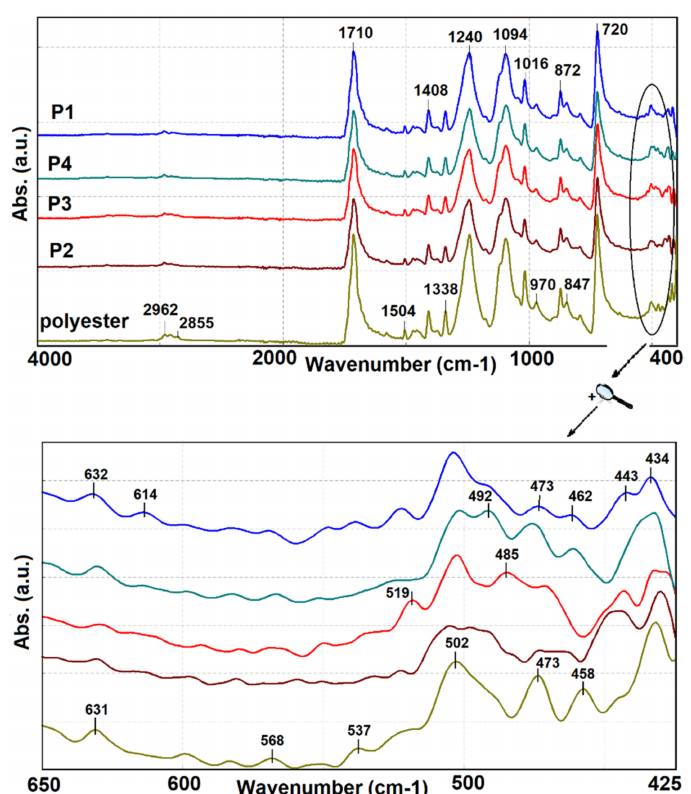
Figure 3. FTIR spectra for polyester fibers coated with nanosols.